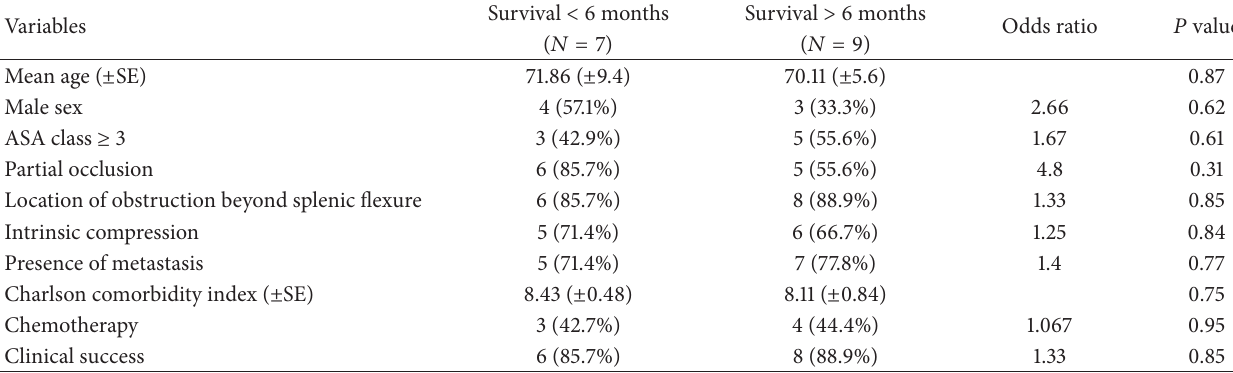
Table 5: Univariate analysis to determine predictors of survival beyond 6 months after stent